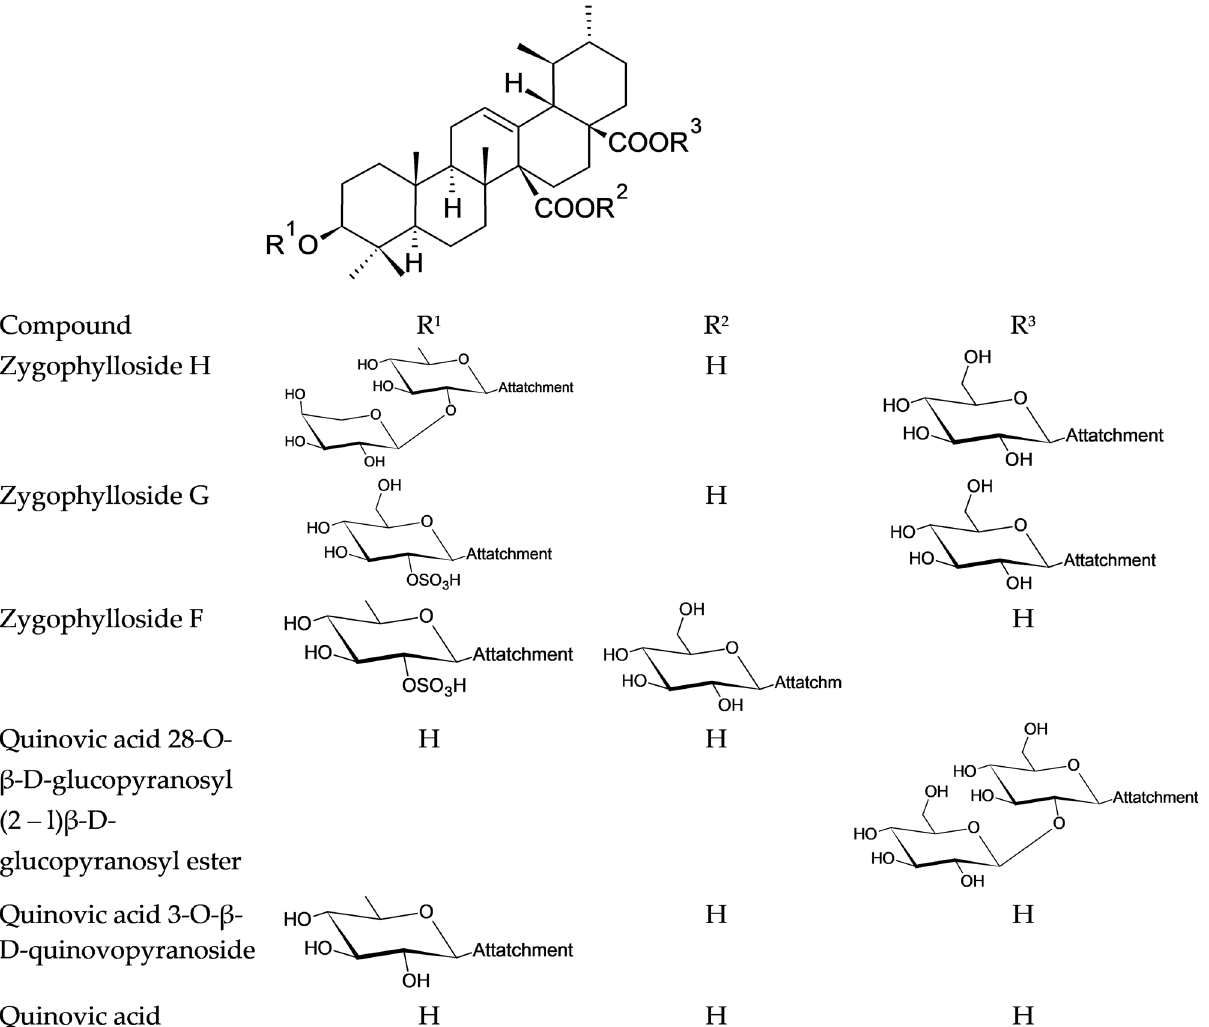
Figure 3. Chemical structures of the main identified saponins in the saponin fraction of Zygophyllum album